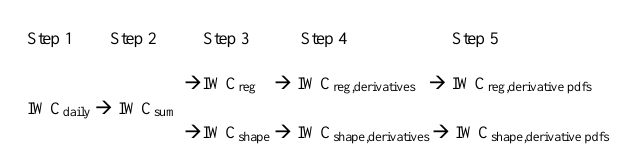
Figure 4. Summary of the processing